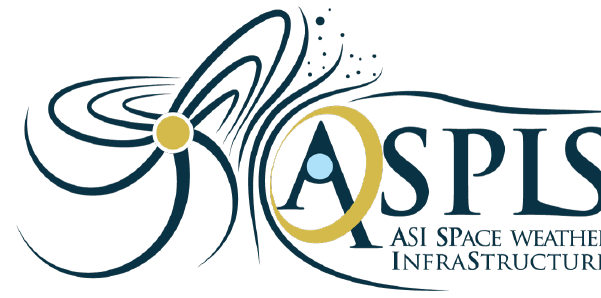
Figure 6. ASPIS logo. Credits to Carmelo